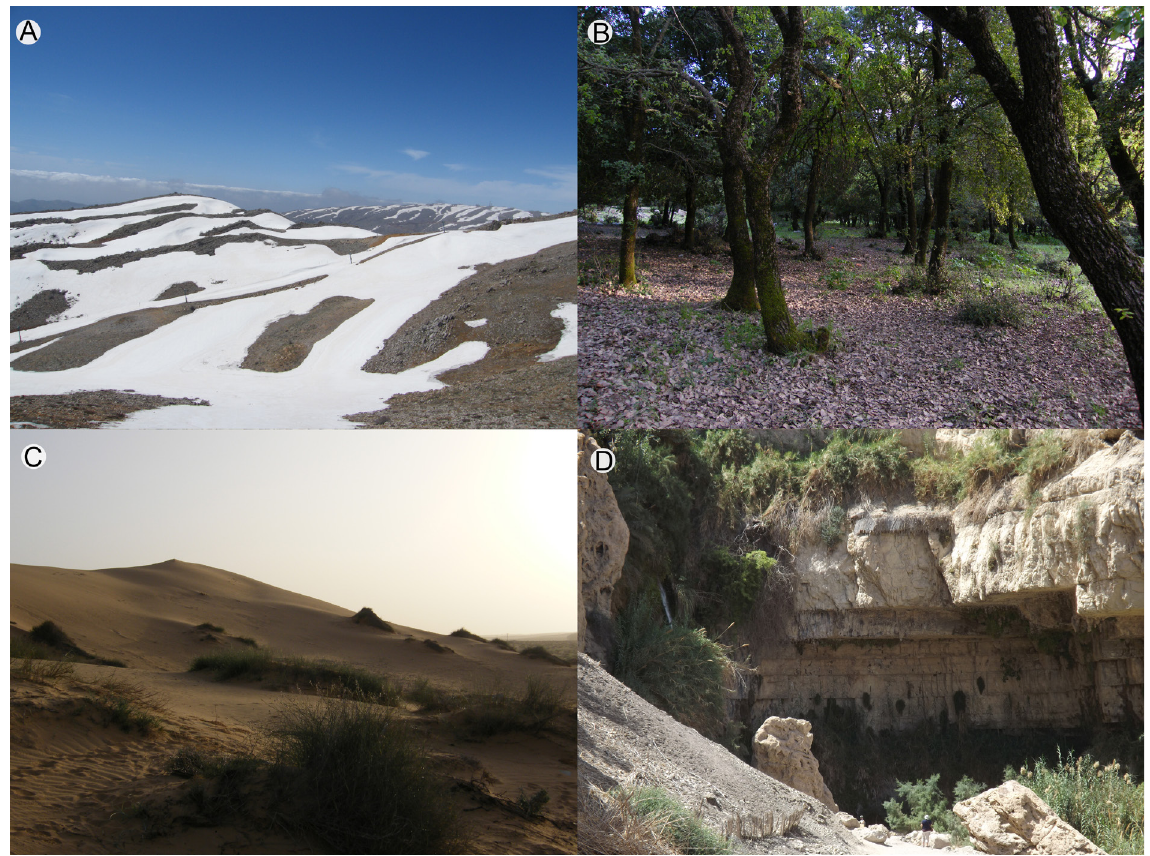
Fig. 25. Lycosa piochardi Simon, 1876, habitat extremes. A . Alpine tragacanth steppe, Mt. Hermon. B . Natural woodland, Odem Forest. C . Sandy desert, western Negev. D . Dead Sea oasis, En Gedi. Photos by I. Armiach